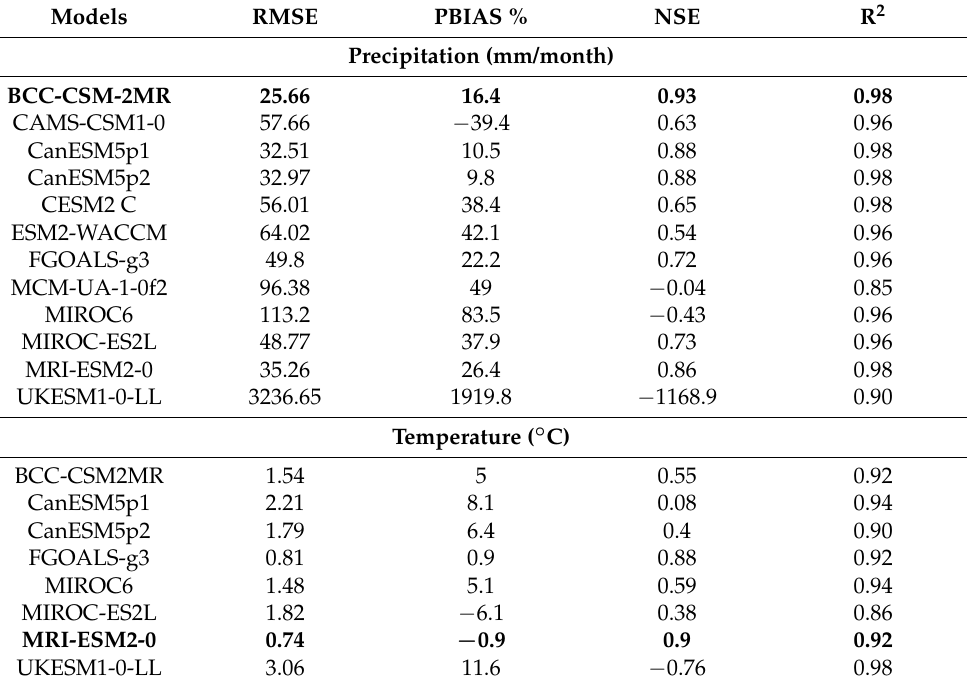
Table 3. Twelve CMIP6 models precipitation and temperature evaluation with observed GPCC and ECMWF-ERA5 using statistical parameters.